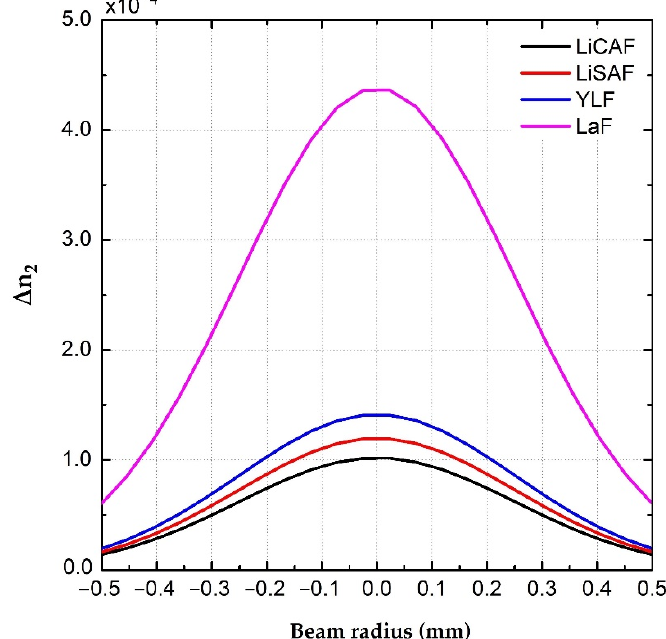
Figure 4. Variation of nonlinear refractive index ( ∆ n 2 ) as a function of the intensity distribution of a Gaussian laser pulse.